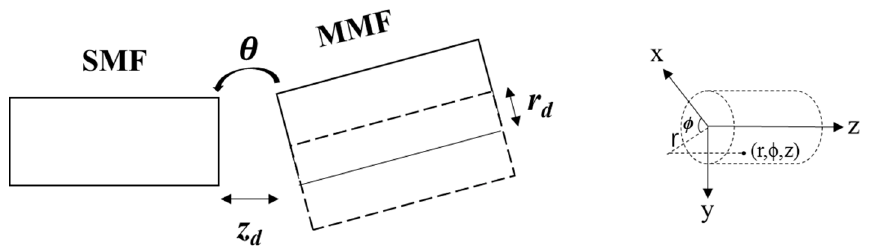
Figure 1. Schematic diagram of the single-mode fiber (SMF) coupled to the multimode fiber (MMF) with a gap z d , along with a lateral core offset r d and a slight tilt θ .